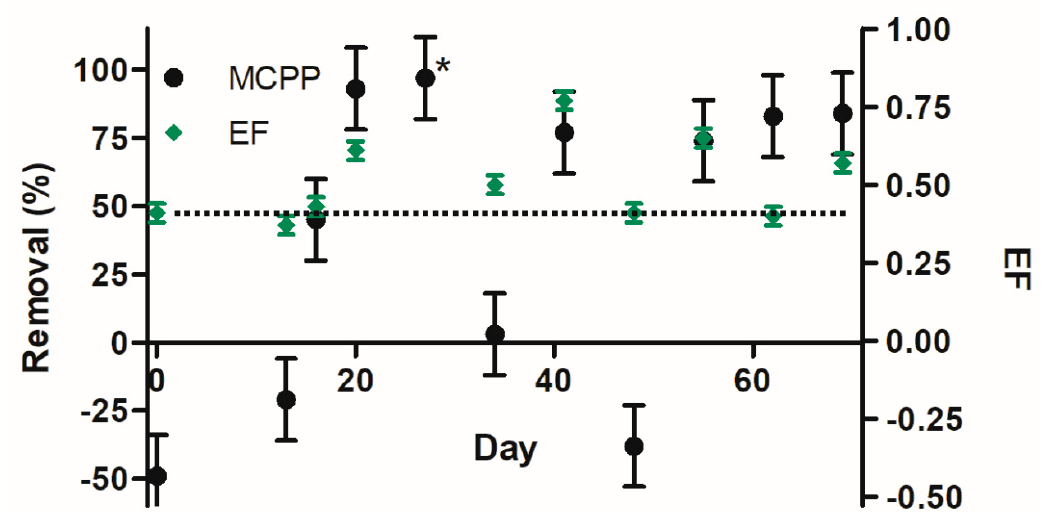
Figure 3. Removal ( ● ) and enantiomeric fractions (EF) ( ■ ) for mecoprop in the sand biofilter. The dotted line represents the average EF (0.41) of the inlet water. The error bars were ±15%, and ±0.03 for removal, and EF, respectively. Asterisks mark the points where C ou t was replaced with LOD.